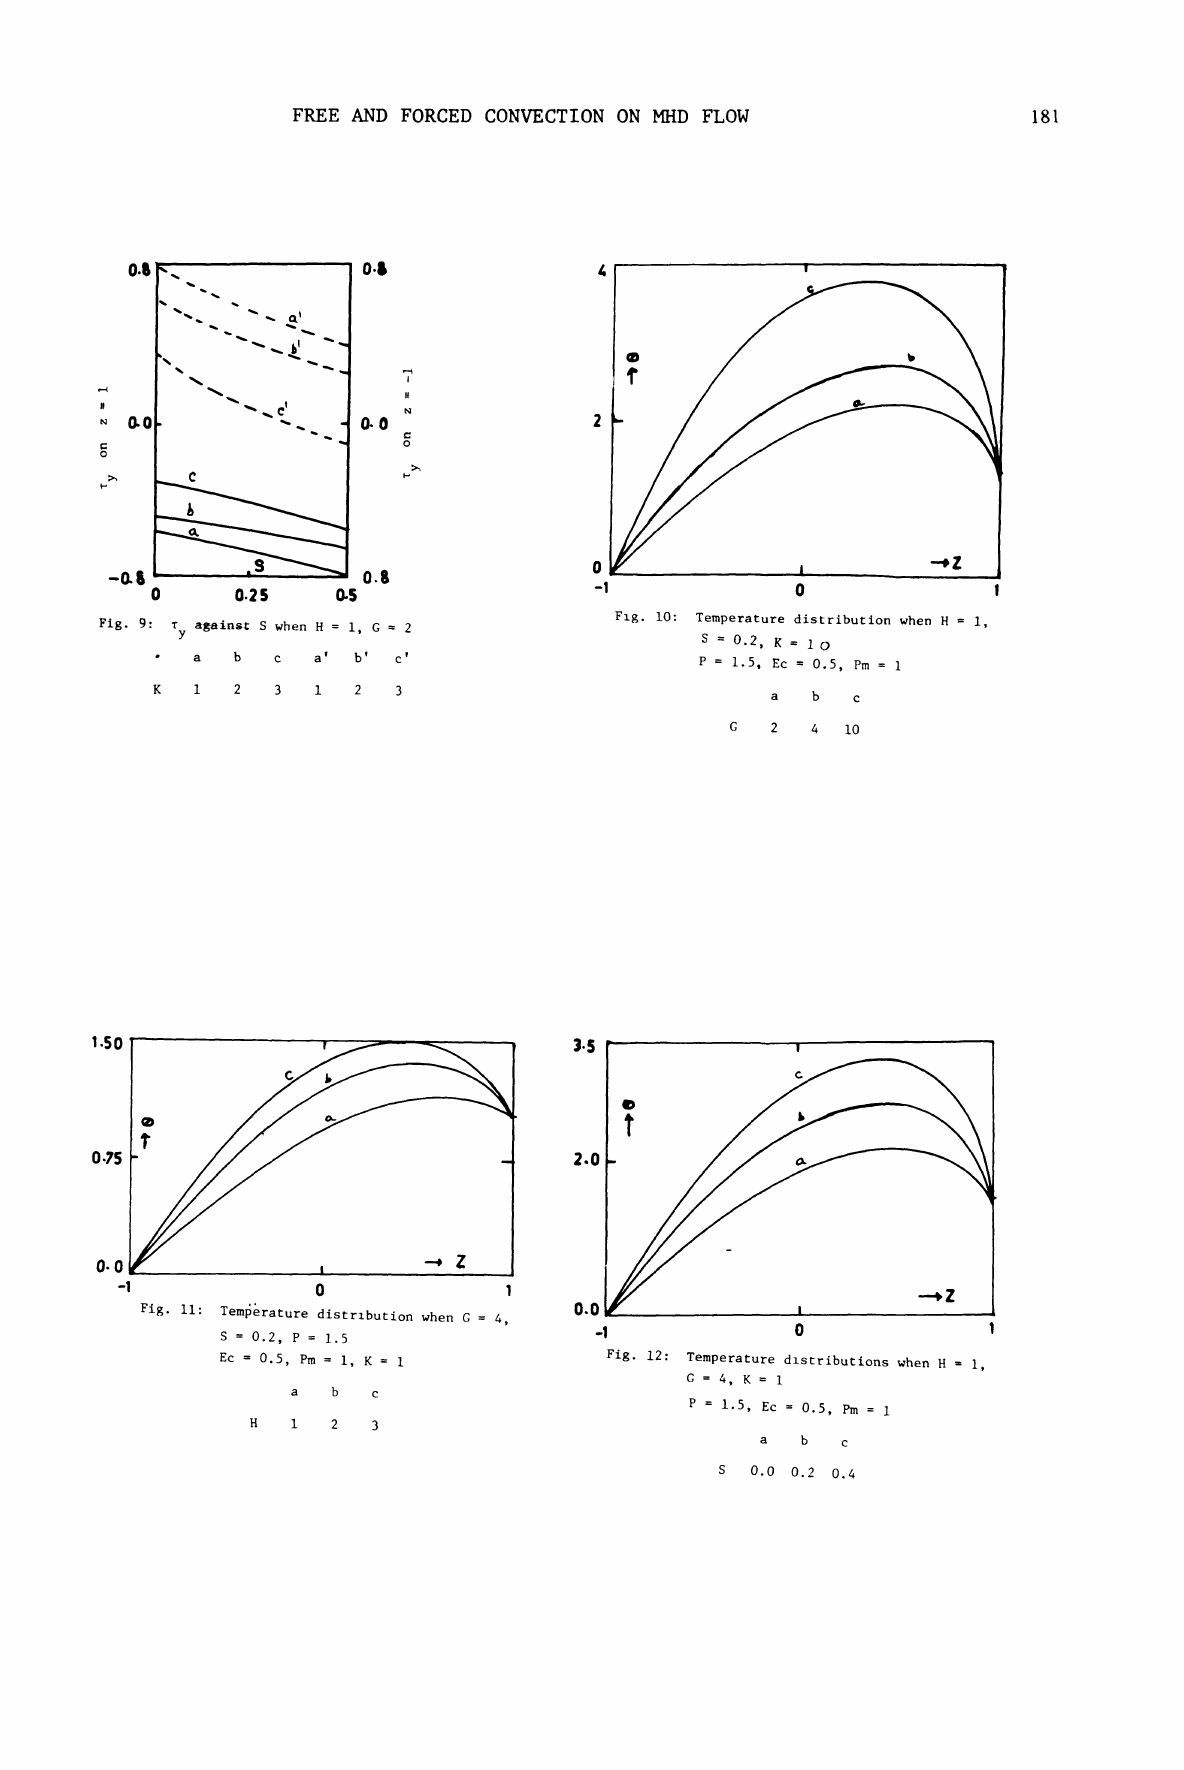
Fig. ii: TemPerature distrxbution when